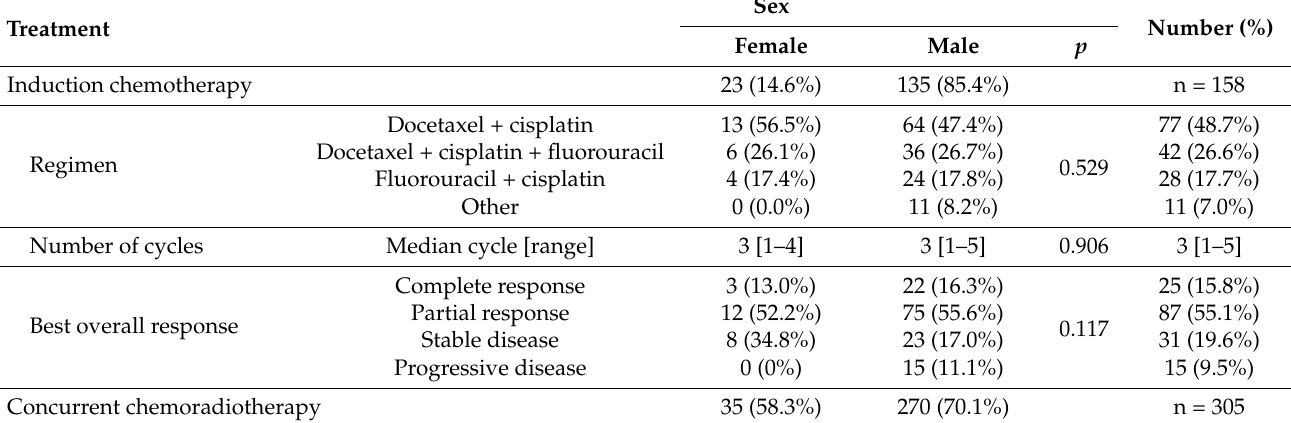
Table 3. Characteristics of treatment modalities in patients with locally advanced head and neck squamous cell carcinoma by